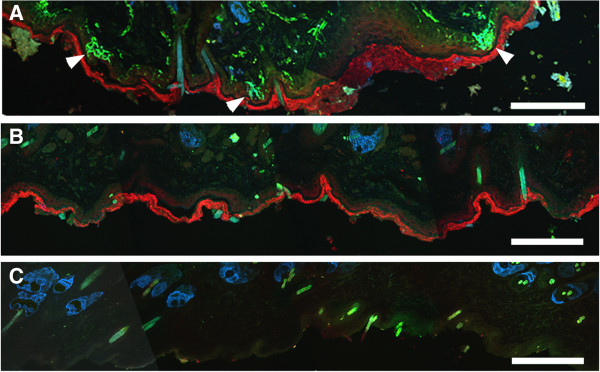
Immunocytochemical labelling and controls. Positive labelling (A) with antibodies to protein gene-product 9.5 (PGP 9.5, green), the high-affinity nerve growth factor receptor TrkA (Tropomyosin-related kinase A, blue) and the neuropeptide Calcitonin gene-related peptide (CGRP, red). Arrowheads indicate intra-epidermal nerve fibres. Pre-absorbing the primary antibodies with an excess of their immunogenic proteins abolished all nerve fibre labelling (B), but the stratum corneum labelling persisted unless the CGRP antibody was omitted (C), presumably due to cross-reactivity of the CGRP antibody with keratin. Dermal sebaceous glands were labelled in pre-absorption (B) and negative controls (C), probably due to endogenous biotin. Hairs autofluoresced and were either FITC or coumarin-blue labelled. Scale bar = 100 μm.